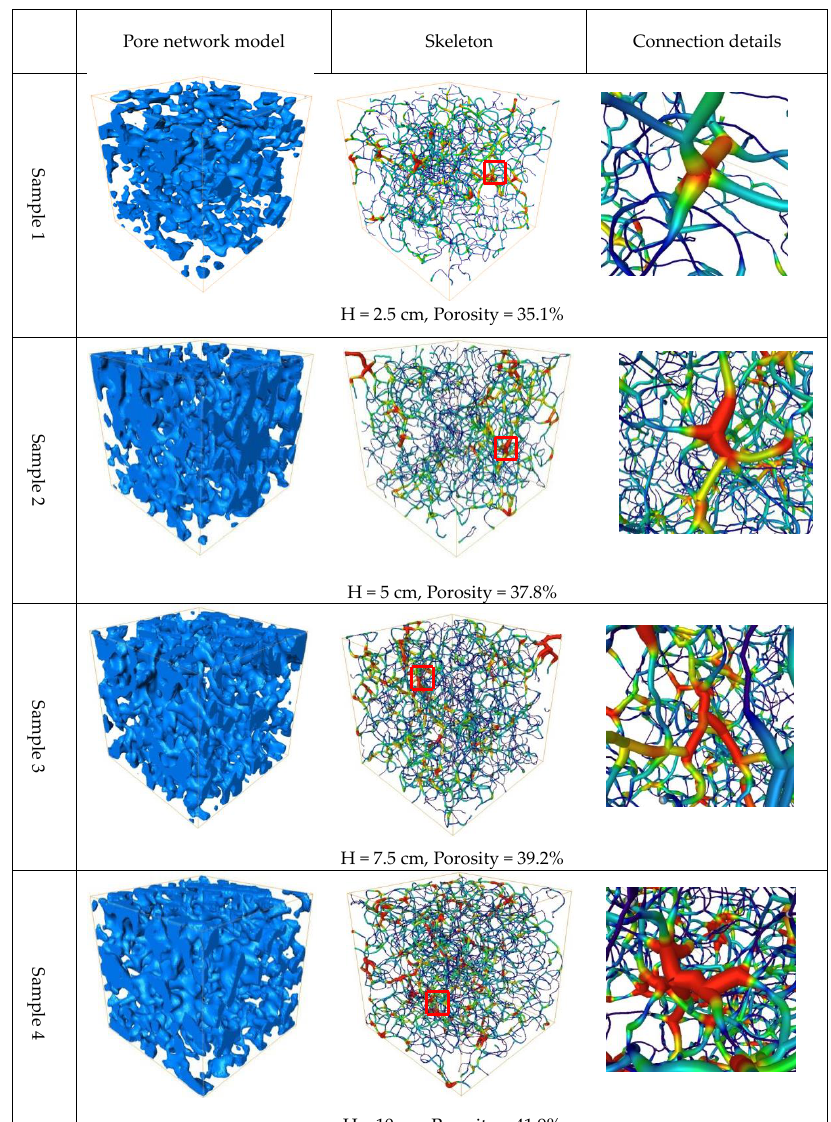
Figure 5. 3D reconstruction result and pore skeleton in a 10-cm tailings bed.